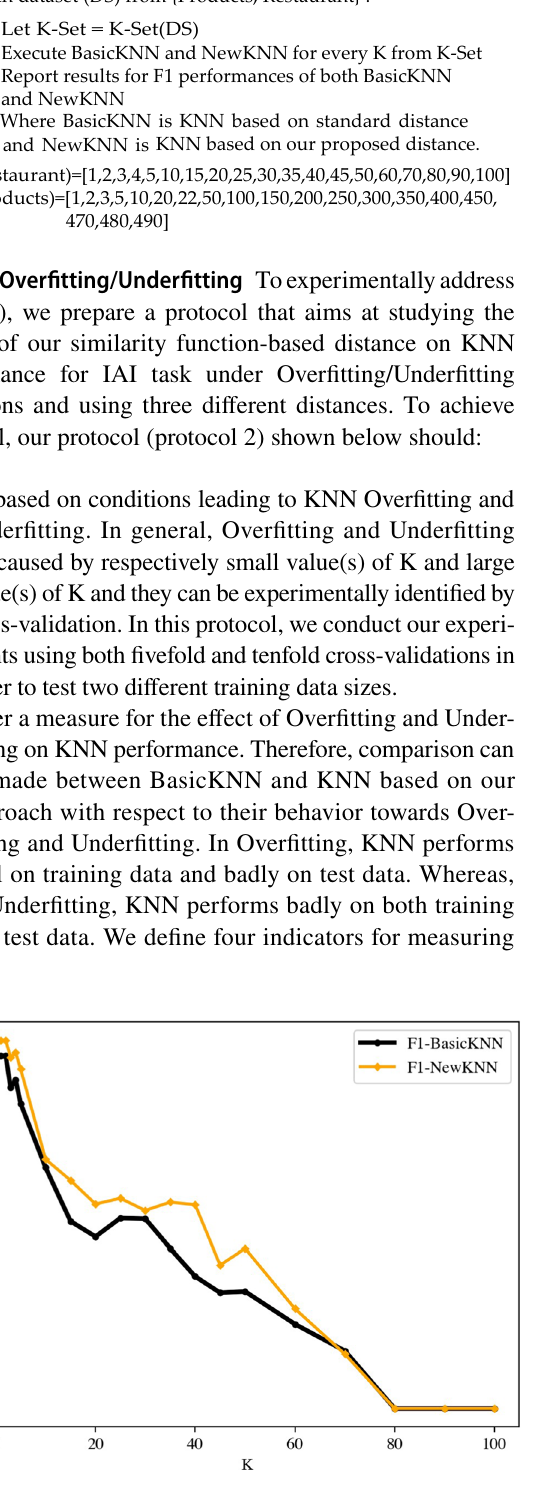
For each Distance (Dist) from {Euclidean, Cosine, Jaccard} : For each dataset (DS) from {Products, Restaurant}